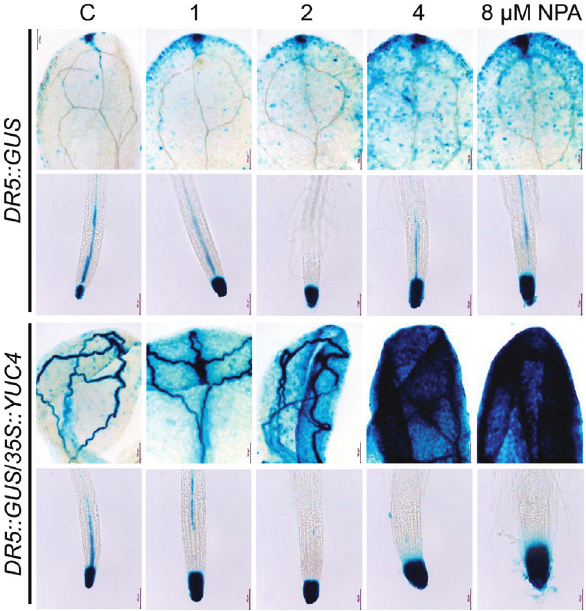
Figure 5 - Auxin responsive gene expression is exacerbated in shoots and roots of 35S::YUC4 seedlings upon NPA treatment. DR5::GUS expres- sion in WT and DR5::GUS / 35S::YUC4 seedlings germinated and grown for 10 d on MS 0.2x medium supplemented with indicated NPA concen- trations. Images show representative seedlings for each treatment (n = 15). The seedlings were processed for histochemical detection of GUS expres- sion,cleared,andphotographed.Notethedose-dependentexacerbatedex- pression of the marker in 35S::YUC4 seedlings treated with NPA. The ex- periment was repeated three times with similar results.